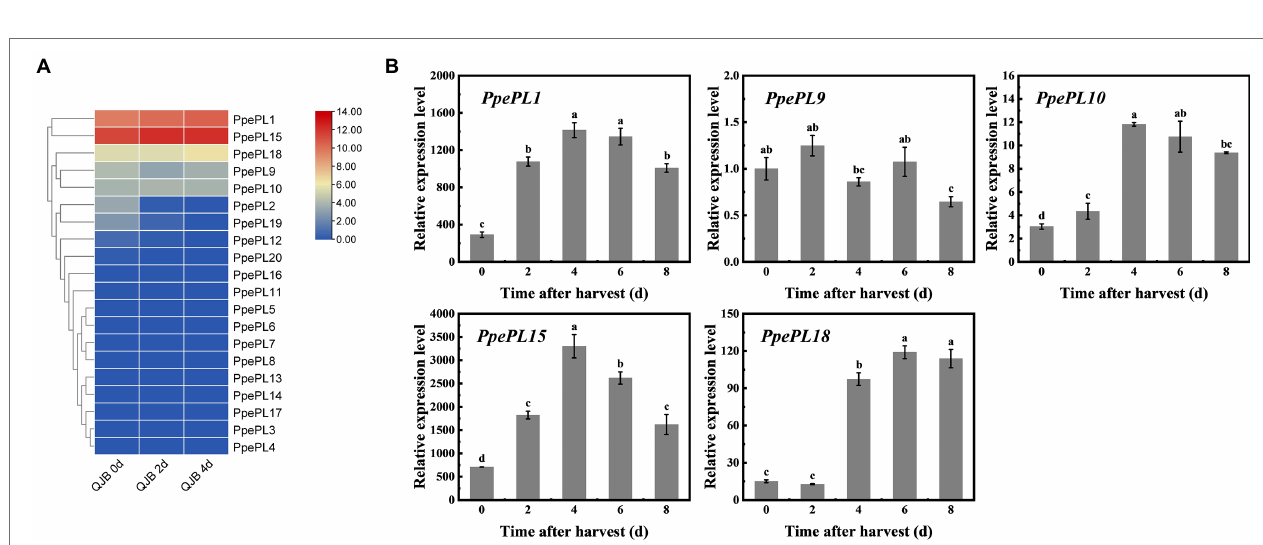
FIGURE 5 | Expression profiles of the PpePL genes in two peach cultivars during storage. (A) PpePL gene expression level in transcriptome data of “QJB” fruit during ripening. Color scale on the right represented log 2 -transformed FPKM values. Red indicated highly expressed genes, while blue indicated low expressed genes. d indicated time after postharvest. (B) Relative expression of PpePL genes in cv. “ZFW” during ripening. PpTua5 and PpCYP2 served as reference gene. Each values represents the means ± standard error of three replicates. Significant differences ( p < 0.05) between means are indicated by different letters.